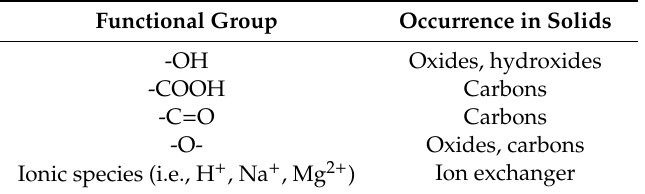
Table 1. Functional groups that a ff ects surface wettability of a solid